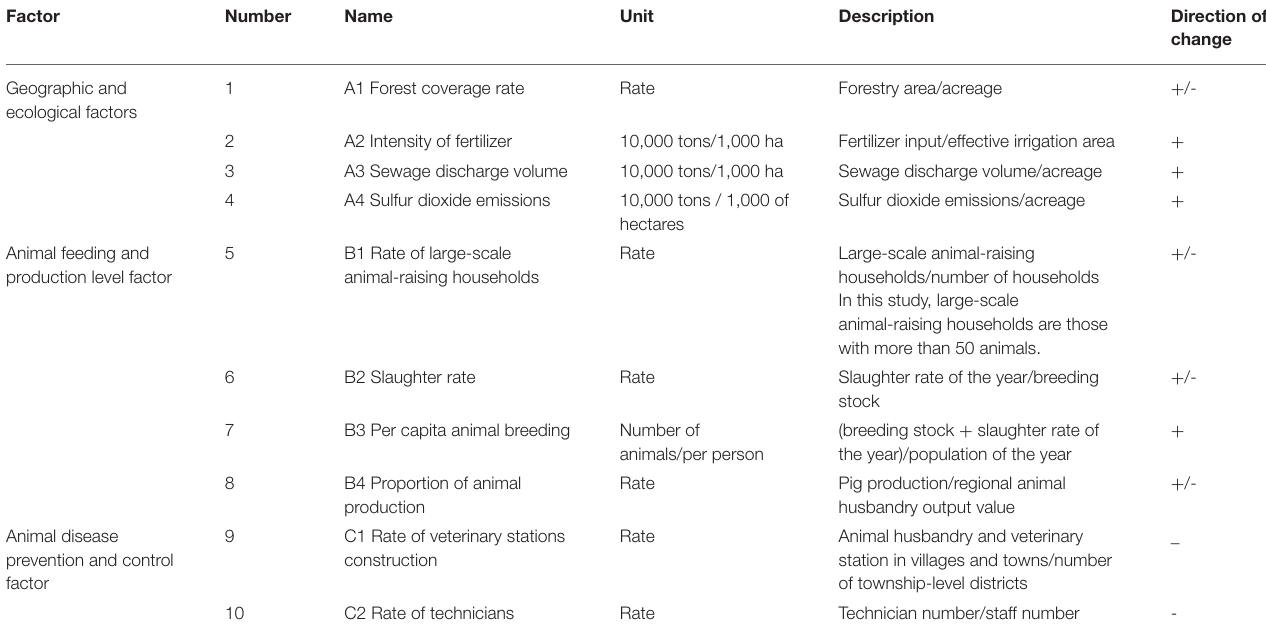
TABLE 2 | Factors influencing the epidemic risk of animal diseases. Factor Number